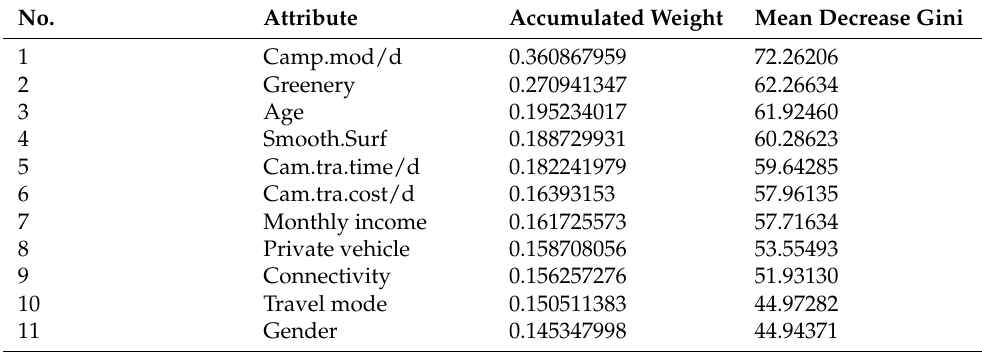
Table 4. Importance of 11 selected variables based on feature selection criteria.